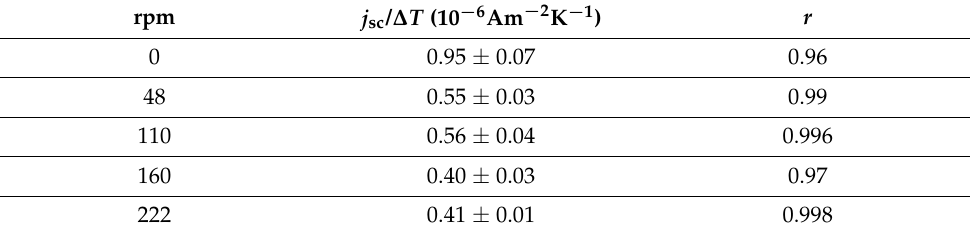
Table 6. Short-circuit current density per K of temperature difference at a mean temperature of 20 o C. Values correspond to linear fits of the experimental data in Figure